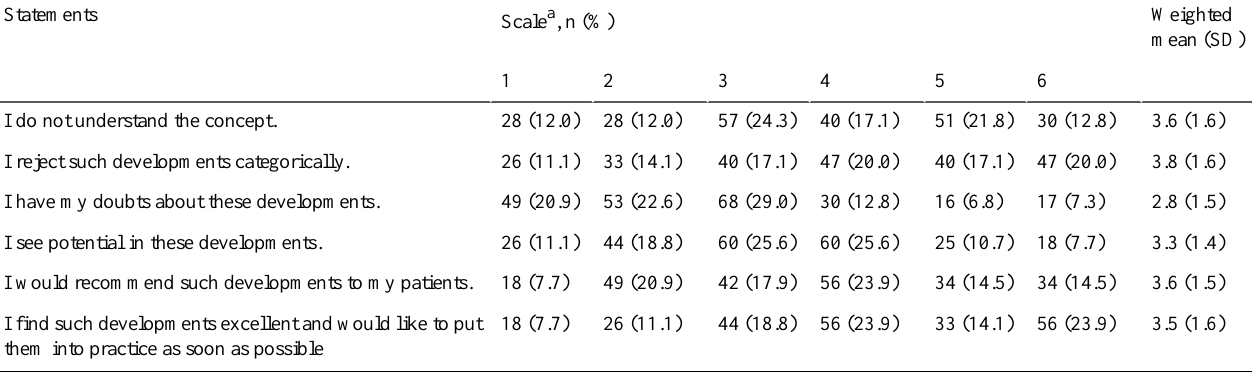
Table 3. Attitude toward the surveillance of pregnant women using telemedicine (N=234).